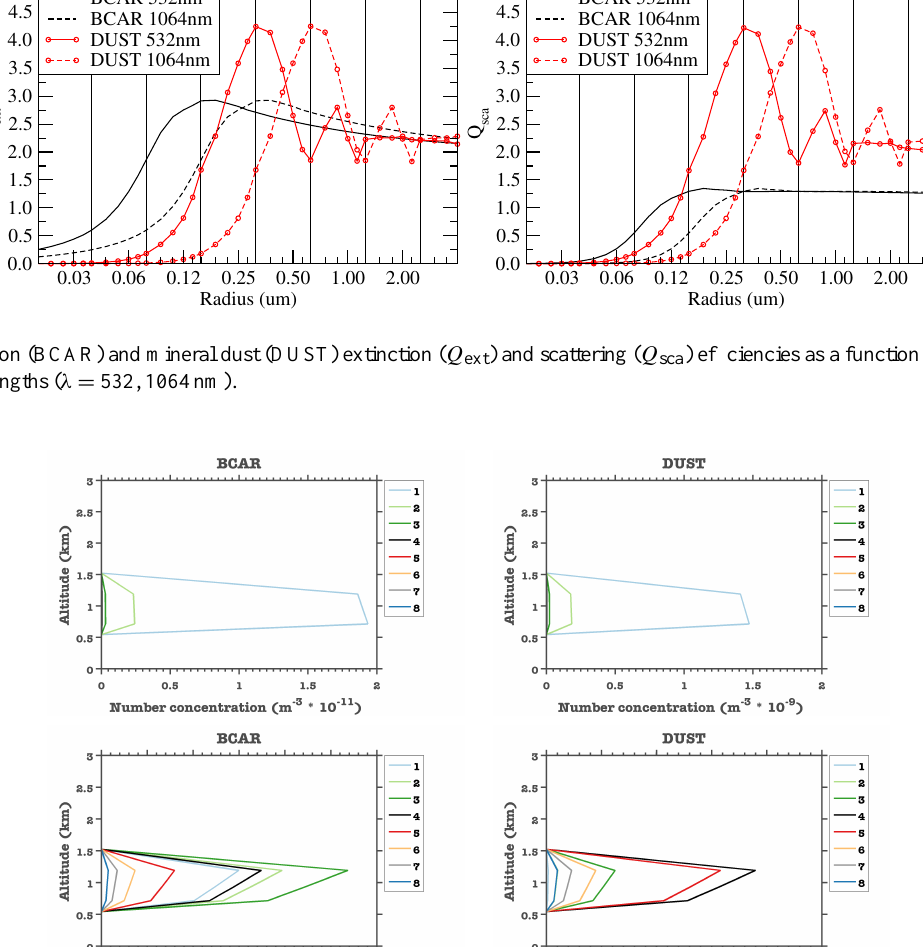
Fig. 3. Profiles of BCAR and DUST concentrations in number and AOD per size section (bin) as a function of altitude and for a wavelength of